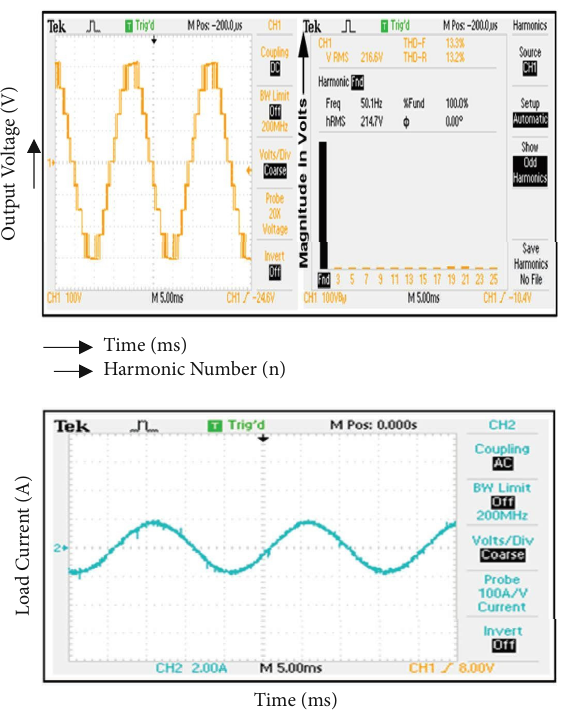
Figure 20: Output voltage waveform and voltage spectrum.